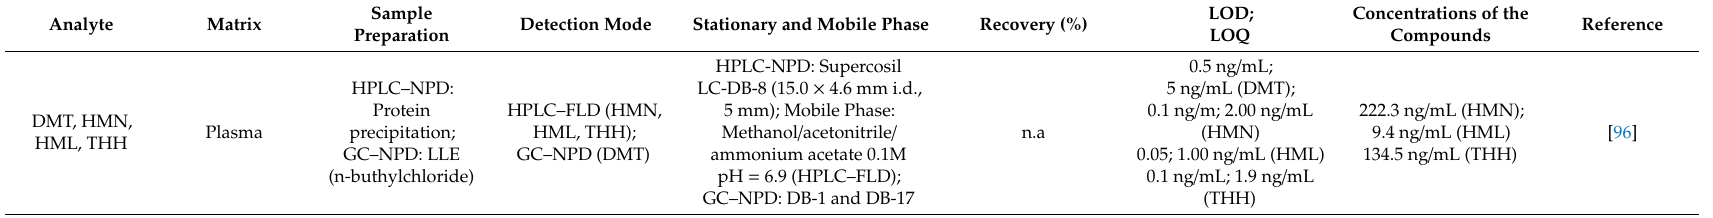
Table 1. Bioanalytical procedures for the determination and quantification of the major compounds of ayahuasca in biological samples and ayahuasca teas or